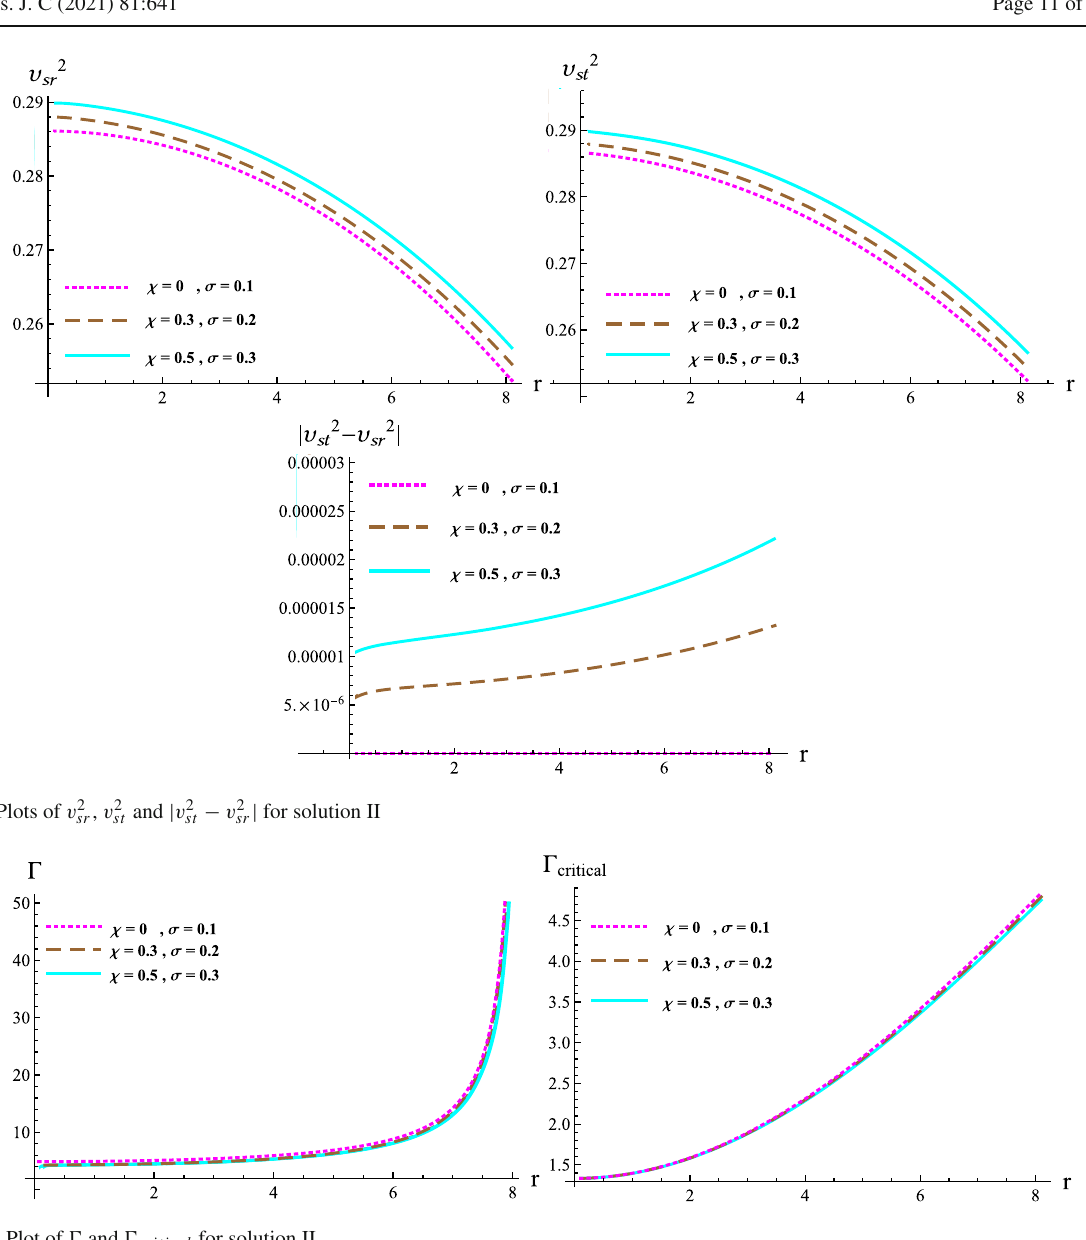
Fig. 10 Plot of (cid:20) and (cid:20) critical for solution II